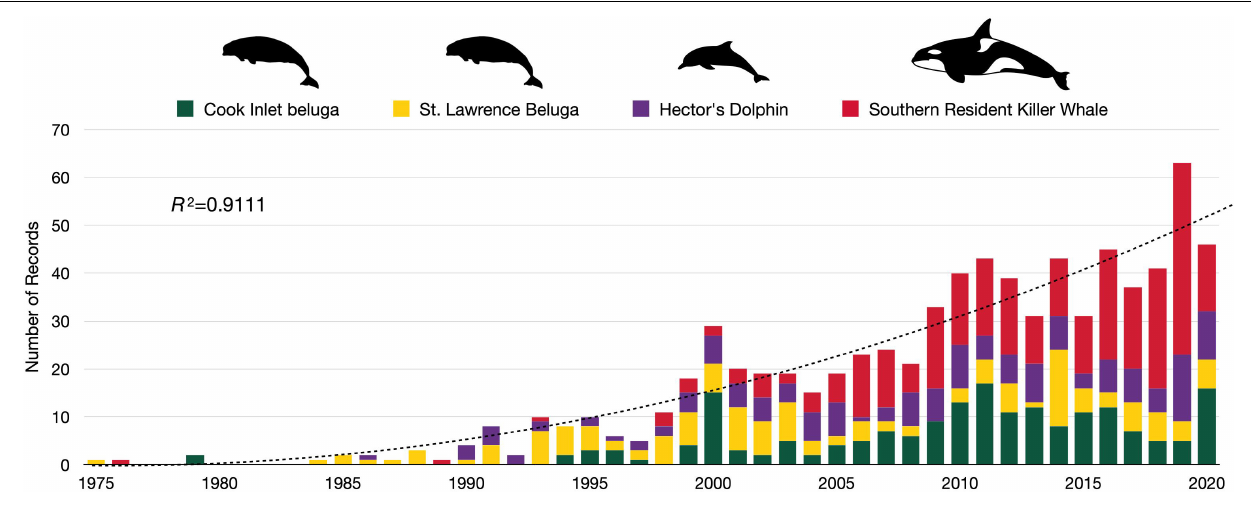
FIGURE 4 | Total number of records for Cook Inlet belugas, St. Lawrence belugas, Hector’s dolphins, and southern resident killer whales, collectively by year (1975–May 2021) (the trendline represents the overall negbinom (#records ∼ year) model.